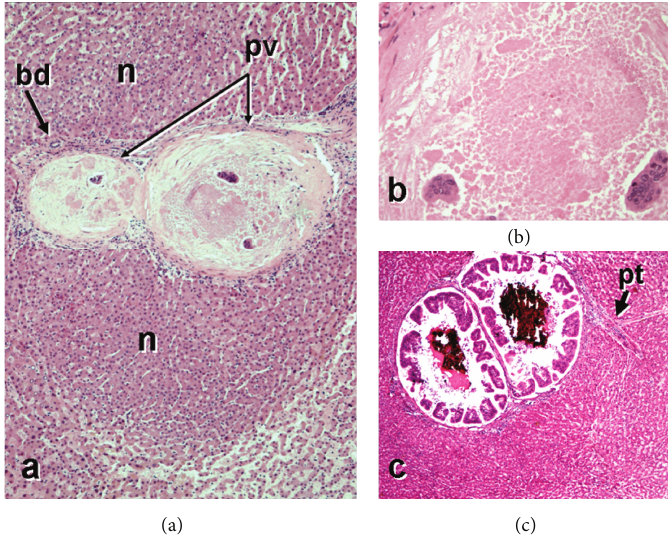
Figure 3: (a) Obstructive portal venopathy due to metastatic breast carcinoma is seen at low power and is associated with periportal regenerative nodules (n), without fibrosis (nodular regenerative hyperplasia). The portal tract is shown at center, including its bile duct (bd) as well as portal vein branches (pv) filled with necrotic tumor. (b) The tumor thrombus within the portal vein branch shows extensive necrosis, with only a few clusters of preserved tumor cells at the periphery. (c) This portal tract (pt) shows breast carcinoma within the portal vein branch, growing with peripherally arranged tubular-glandular units and prominent central necrosis with calcification. (Hematoxylin and eosin stain, original magnification (a) × 40; (b) × 200; (c) × 40.)